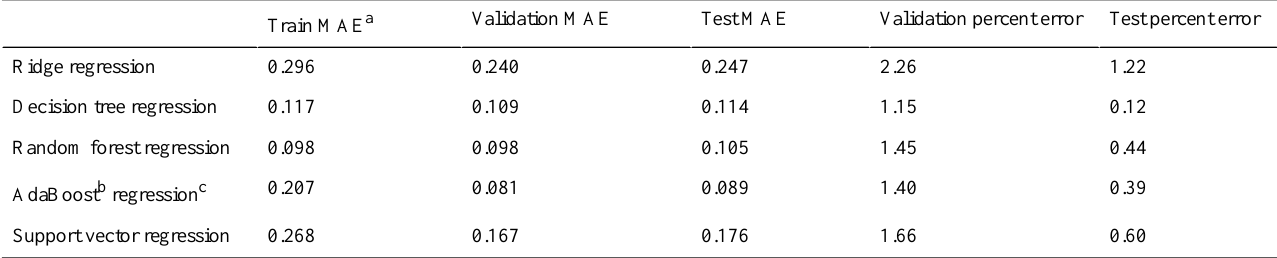
Table 6. Optimal MAE and median percent error values for the out-of-distribution validation method.